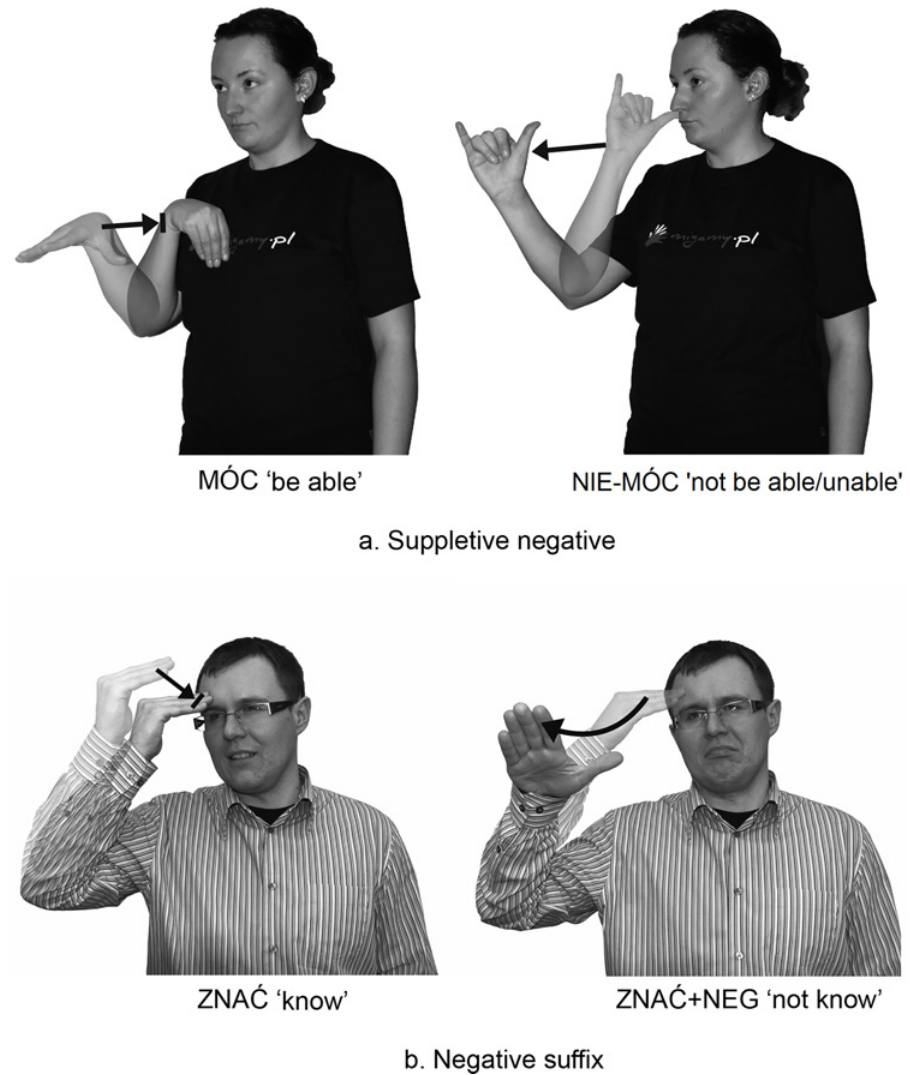
Fig 6. Examples of a suppletive negative and a negative suffix. The two individuals in this figure have given written informed consent (as outlined in PLOS consent form) to publish these case details.